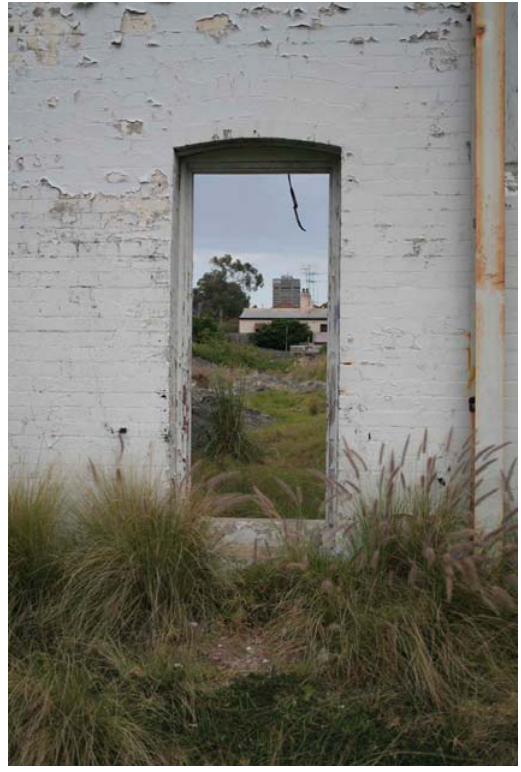
Figure 7. Edwin Davey Flour Mill and UTS tower